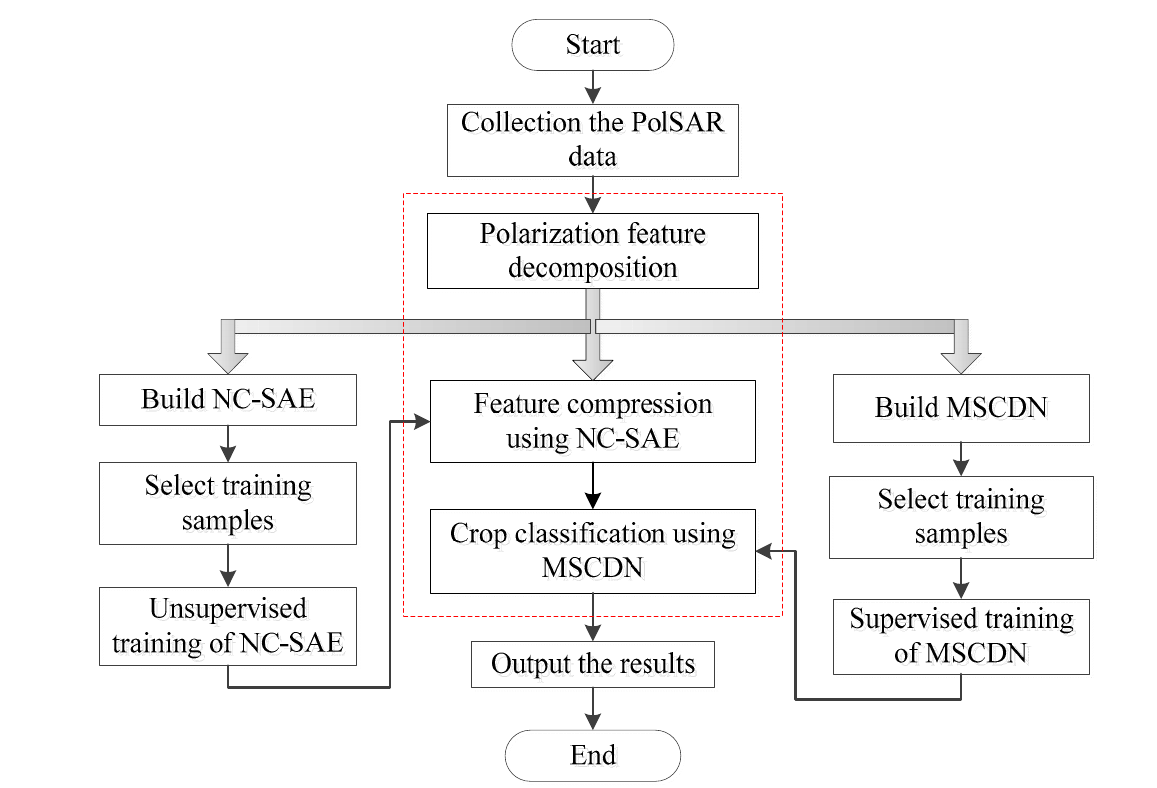
Figure 1. Flowchart of the whole study method.